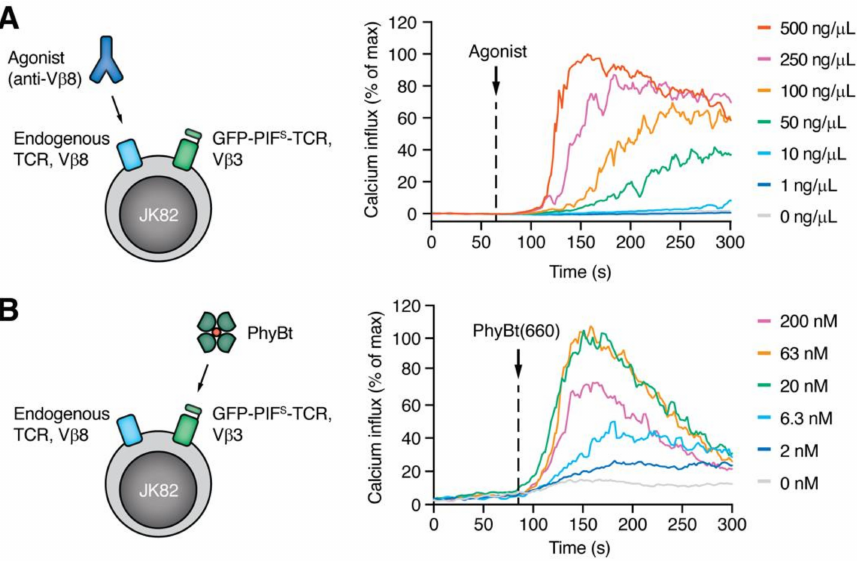
Figure 2. TCR ligand titration. Calcium influx into JK82 cells was measured upon treatment with different concentrations of anti-V β 8 ( A ) or with PhyBt ( B ). PhyBt was pre-illuminated with 660 nm light (PhyBt(660)) to switch PhyB to the GFP-PIF S -TCR-binding conformation. One representative experiment of n = 3 is